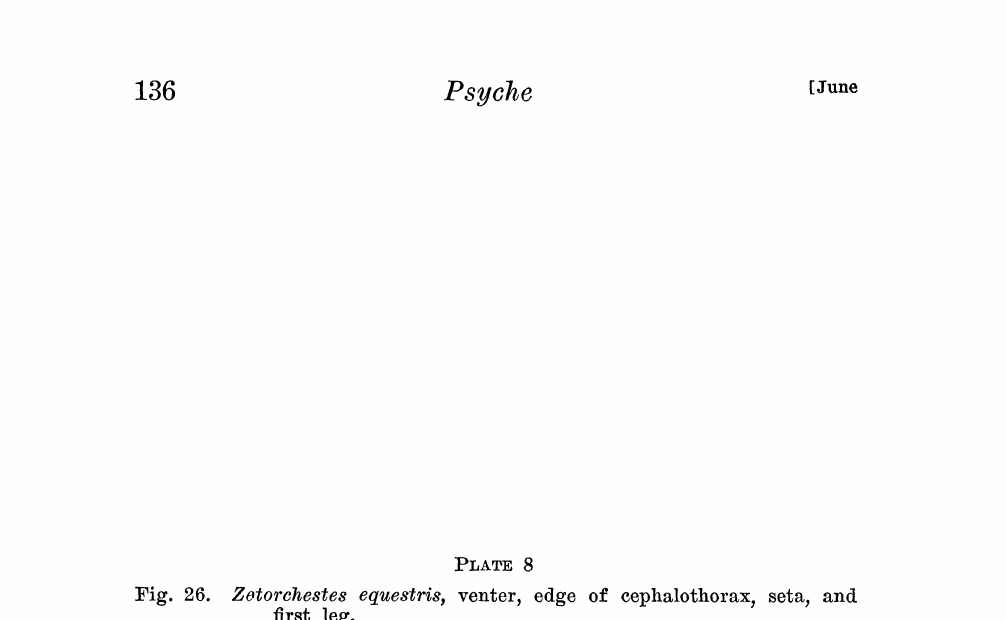
PLATE 8 Zotorchestes equestris, renter, edge of cephalothorax, seta, and first leg. Gymnodamus pearsei, first tibia and tarsus, seta, tip of cephalo- thorax, and attachment of first leg. Gymnodamus minor, first leg, showing ibia beneath, tibia and tarsus of first leg, showing ibia from side, fourth leg. Carabodoides retracta, renter, seta, and first leg and edge of eephalothorax. Fig. 3O. Erythreus exiipes, palpus from two views. Fig. 31. Oribata civersipes, cephalothorax, and